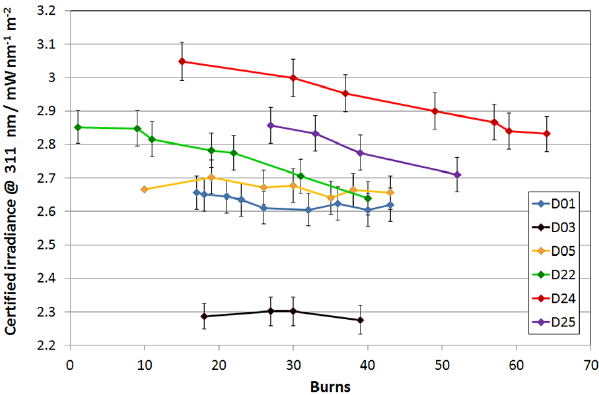
Figure 5. Ageing rate of the primary standard lamps used in cali- bration of Brewer #037 in Sodankylä and Brewer #107 in Jokioinen, given by the NSL-certified irradiance at 311nm as a function of the number of burning